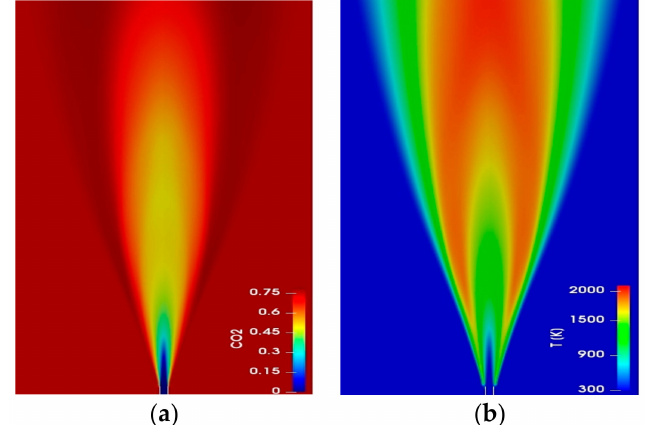
Figure 5. Contour plots from ESF/FPV simulation for Oxyfuelflame B3: ( a )Temperature distribution, ( b ) meanCO 2 mass fraction.